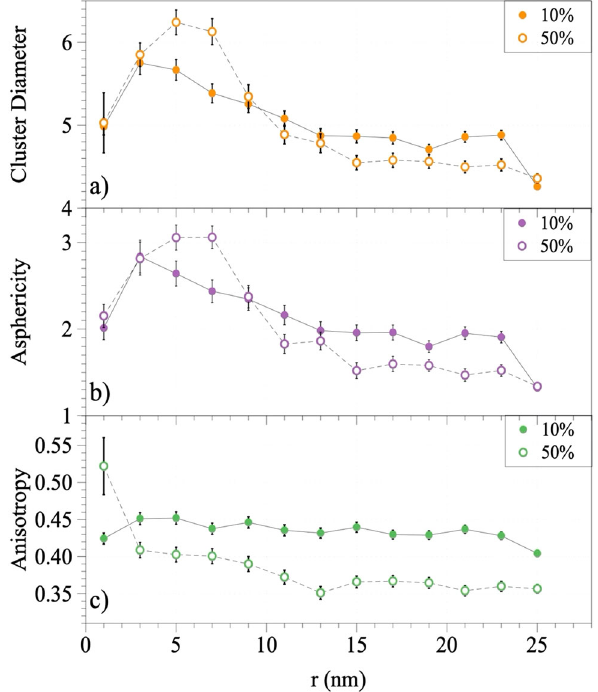
Fig. 10 Detailed physical properties of the corona clusters at the surface of polystyrene NPs. Plots of a the average cluster diameter distribution, b asphericity, and c anisotropy calculated via the eigenvalues of the gyration tensors of the corona clusters for the 10% ( fi lled circles) and 50% (hollow circles) plasma concentration samples. The horizontal axis shows the distance of the clusters from the surface of the NPs. Error bars = standard deviation ( n = 12 for the 10% concentration, and n = 9 for the 50% plasma concentration). range from 0 to 1).